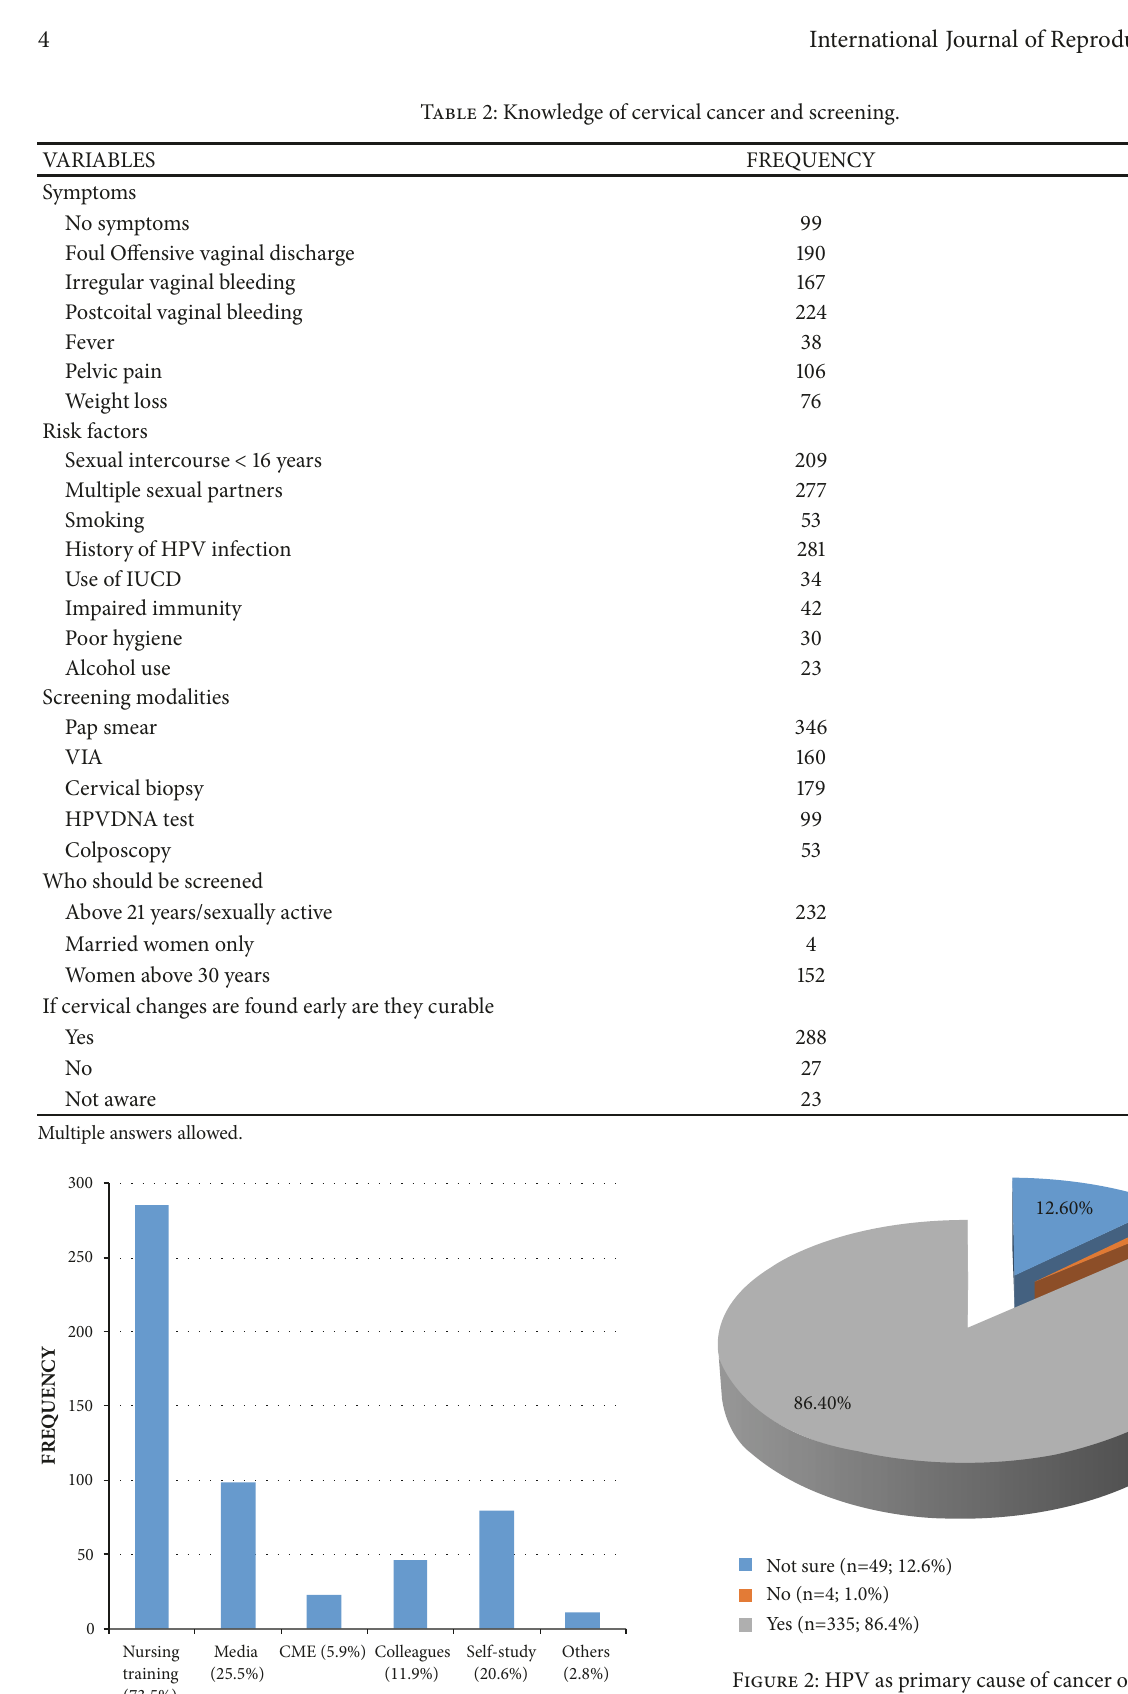
Figure 2: HPV as primary cause of cancer of the